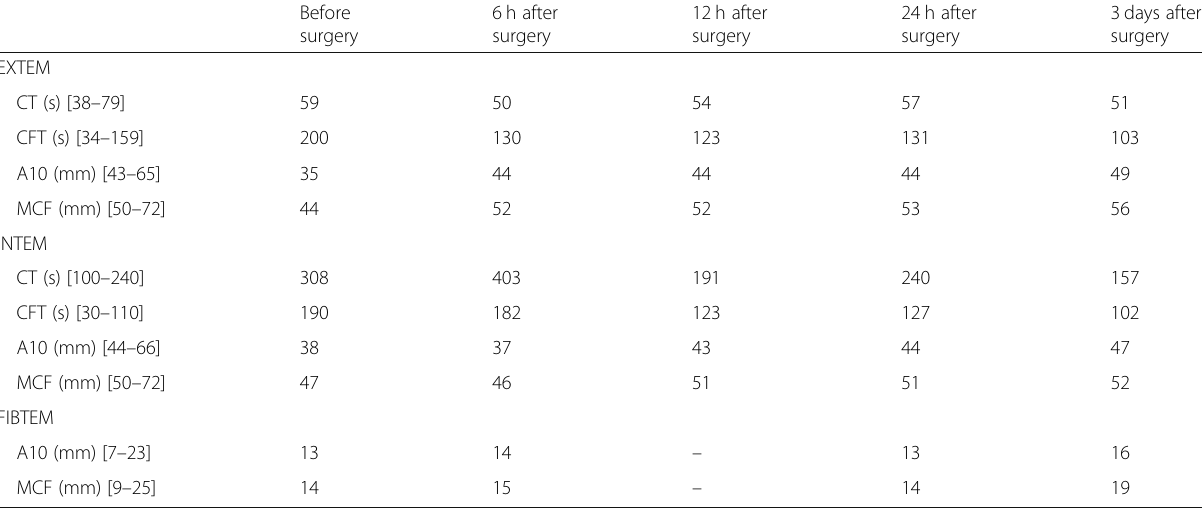
Table 2 ROTEM findings